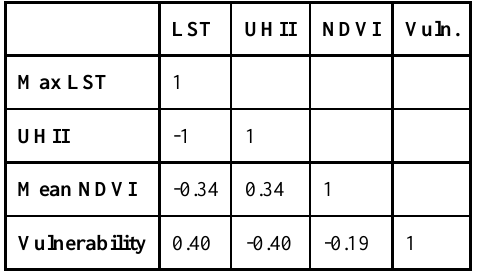
Table 5. Pearson correlation coefficients for Phoenix.